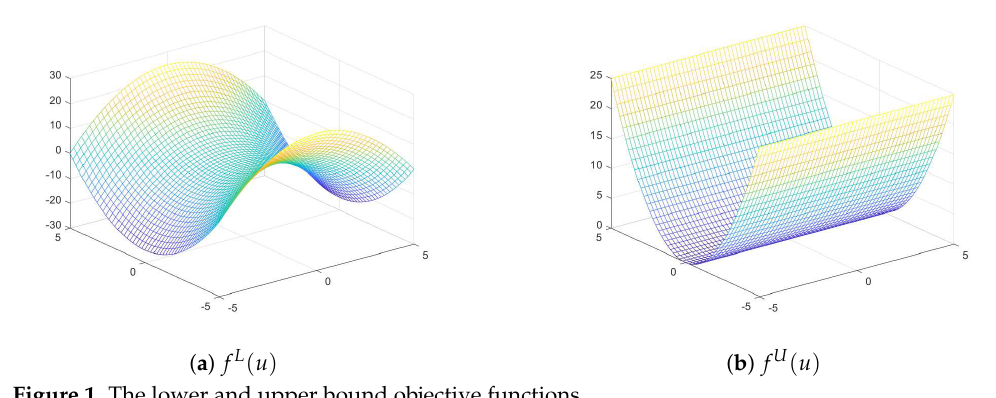
Figure 1. The lower and upper bound objective functions.